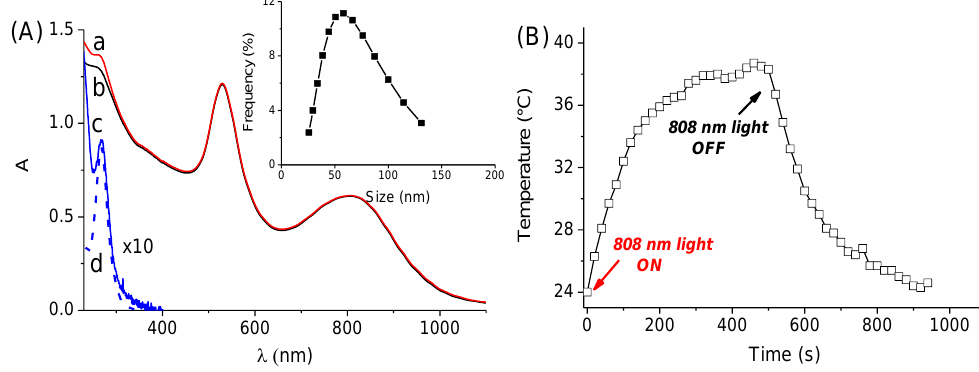
Figure 4. ( A ) Absorption spectrum of an aqueous dispersion of Au@PolyCD after (a) and before (b) stirring overnight with a thin film of SRB. Difference absorption spectrum between a and b (c) and absorption spectrum of a solution of PolyCD (2 mg mL −1 ) encapsulating SRB at the same concentra- tion as in a (d); spectra c and d are multiplied for a factor of 10 for sake of clarity. The inset shows the size distribution of sample a measured by DLS. ( B ) Temperature changes observed upon 808 nm CW laser irradiation (6 W cm −2 ) of the Au@PolyCD@SRB complex (sample a). RD‑NO, an NOPD recently developed in our group [36], consists in a rhodamine an‑ tenna covalently linked to an N‑nitroso appendage through a flexible spacer. Release